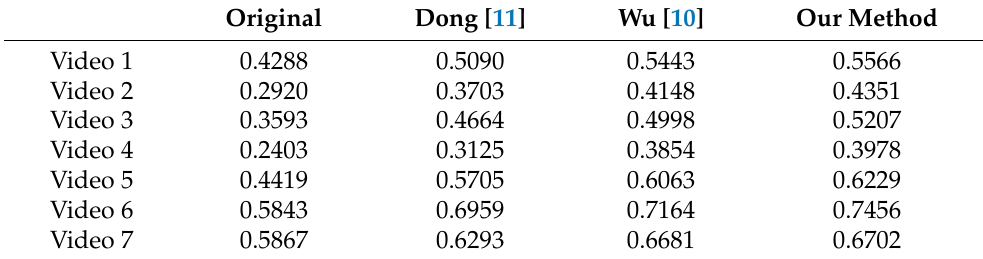
Figure 9. The tested image group: ( a ) shaky videos with large foreground, ( b ) shaky videos with multi-object. Table 6. SSIM for shaky videos with large foreground.